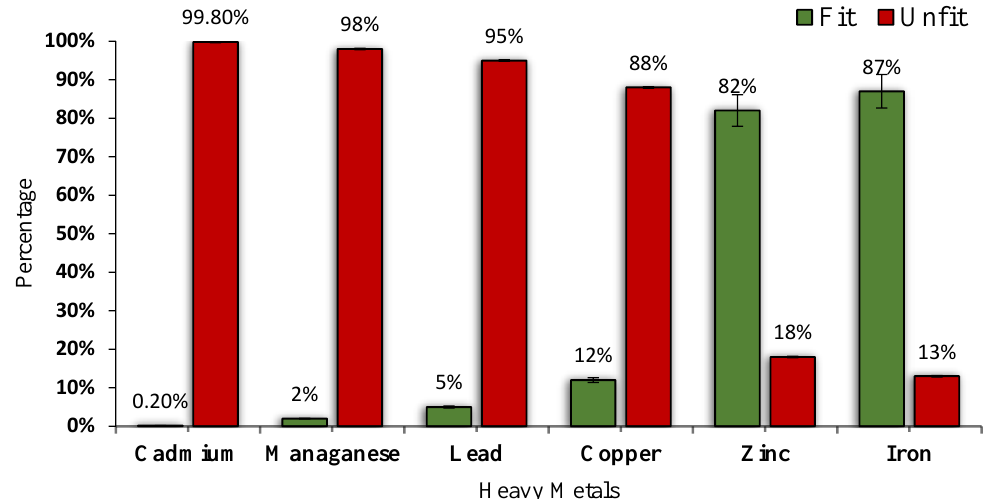
Figure 6. Status of heavy metals in collected water samples from Tehsil Fort Abbas. Table 2. Descriptive analysis of studied variable of the irrigation water of sampling sites with the permissible limits.